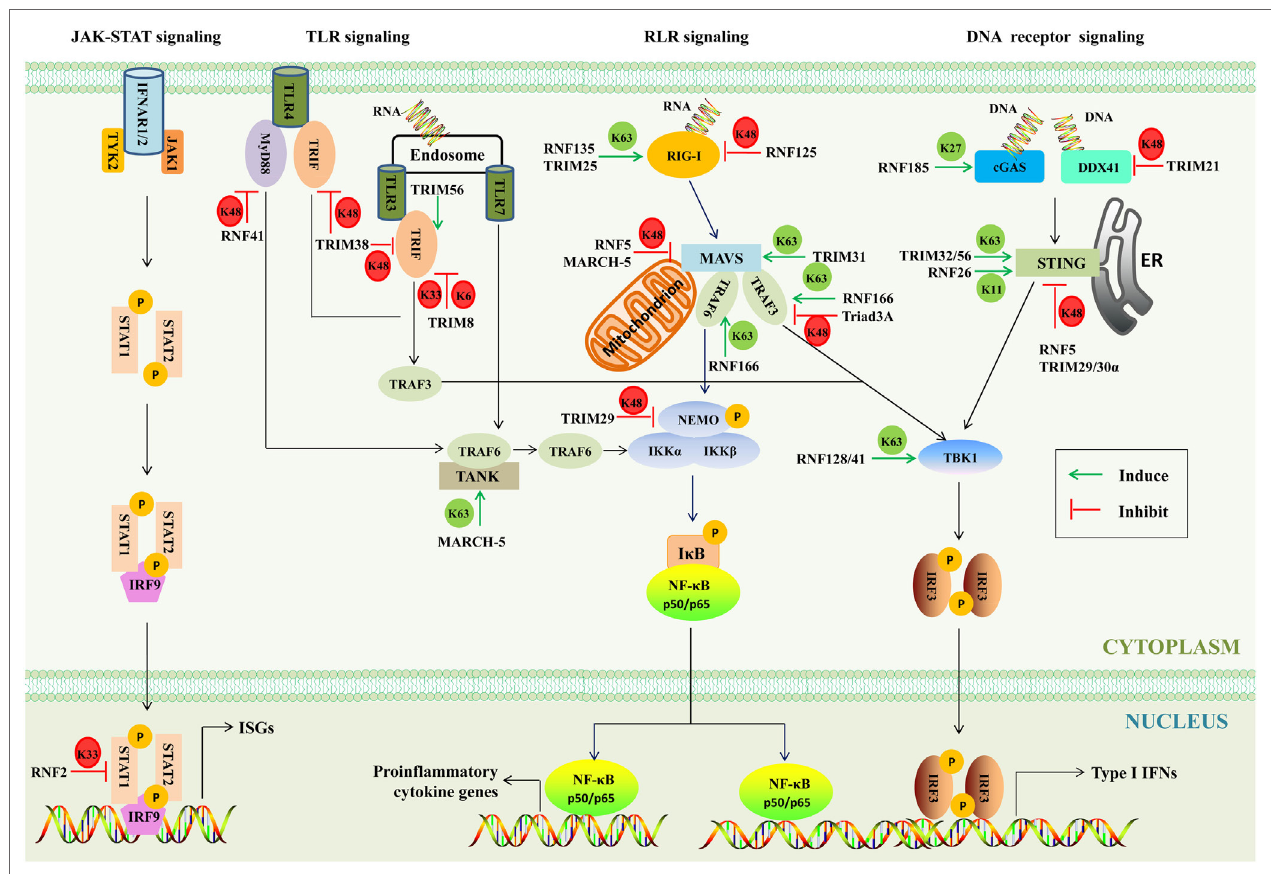
FiGURe 4 | The involvement of RING-domain E3 ligases in mediating innate immunity-associated signaling pathways. The major adaptors are indicated. Abbreviations: RIG-I, retinoic acid-inducible gene I; cGAS, cyclic GMP-AMP synthase; DDX41, DEAD box polypeptide 41; STING, stimulator of interferon genes; TBK1, TANK-binding kinase 1; IRF3 and 9, interferon regulatory factors 3 and 9; MAVS, mitochondrial antiviral signaling; NF- κ B, nuclear factor κ B; NEMO, NF- κ B essential modulator; I κ B, inhibitory κ B; IKK, inhibitor of κ B kinase; TLR3, 4, and 7, toll-like receptors 3, 4, and 7; MyD88, myeloid differentiation primary response protein; TRIF, TIR-domain-containing adaptor protein inducing interferon- β -mediated transcription factor; TRAF, tumor necrosis factor receptor-associated factor; IFN, interferon; TANK, TRAF family member-associated NF- κ B activator; IFNAR, type I IFN receptor; JAK-1, Janus kinase 1; TYK2, tyrosine kinase 2; STAT1 and 2, signal transducer and activator of transcription 1 and 2; ISGs, IFN-stimulated genes; TRIM, tripartite motif-containing; MARCH, membrane-associated RING-CH; K6, K6-linked polyubiquitination; K11, K11-linked polyubiquitination; K27, K27-linked polyubiquitination; K33, K33-linked polyubiquitination; K48, K48-linked polyubiquitination; K63, K63-linked polyubiquitination; P, phosphorylation; ER, endoplasmic